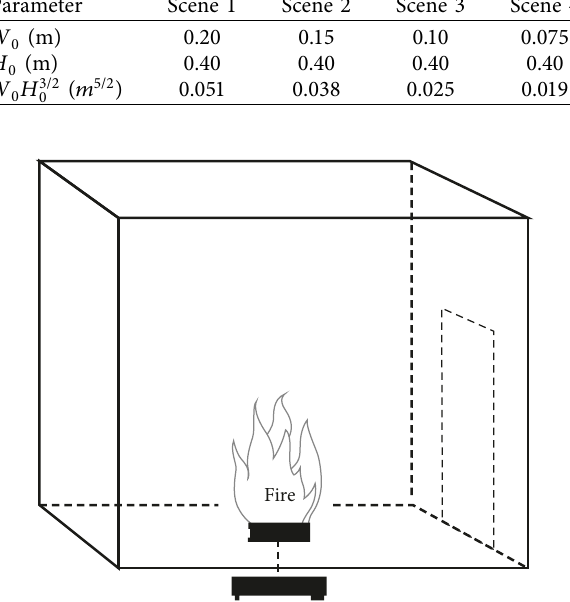
Figure 2: Illustration of the experimental room with electronic balance used to measure the mass loss rate of fuel during fire